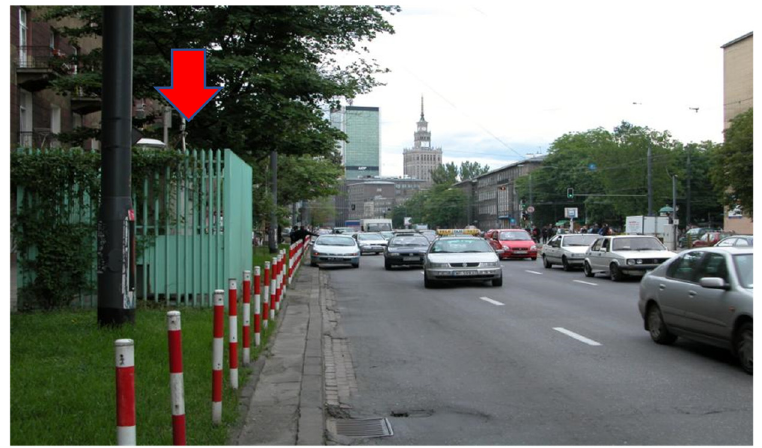
Figure 1. Traffic air quality monitoring station in Al. Niepodleg ł o ś ci in Warsaw, located directly next to the roadway.